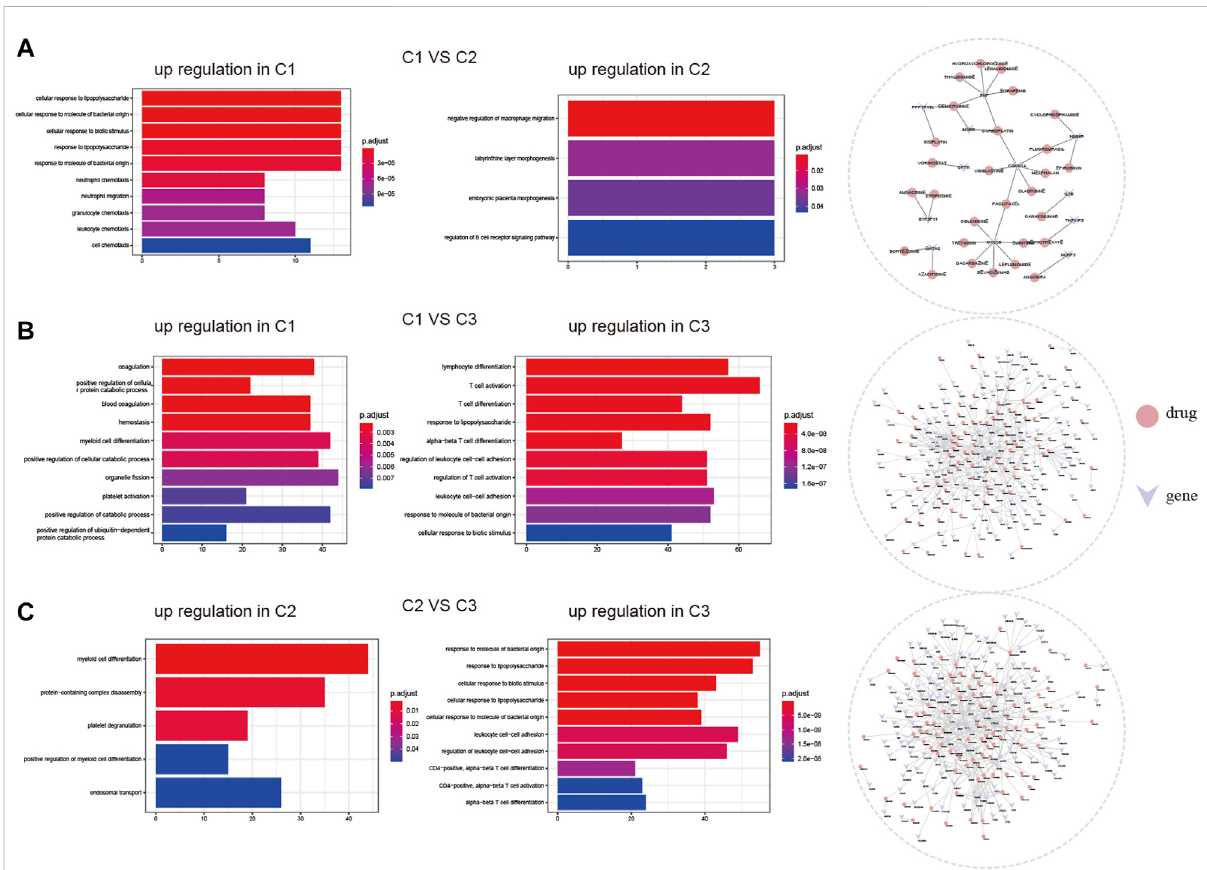
FIGURE 6 Diversity of underlying biofunctional characteristics among three ischemic stroke subtypes. (A) , (B) , and (C) Upregulated gene enrichment among the three subtypes, pairwise comparisons were made for GO-biological processes, and potential drug targets predicted by DGIdb,